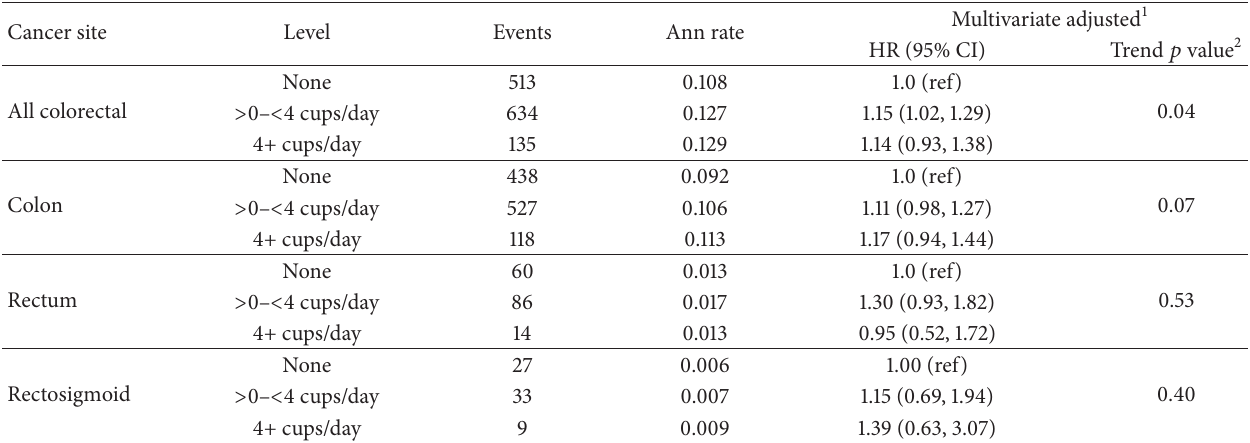
Table 2: Proportional Hazards analysis of the relationship between regular coffee consumption and incident colorectal cancer. Cancer site